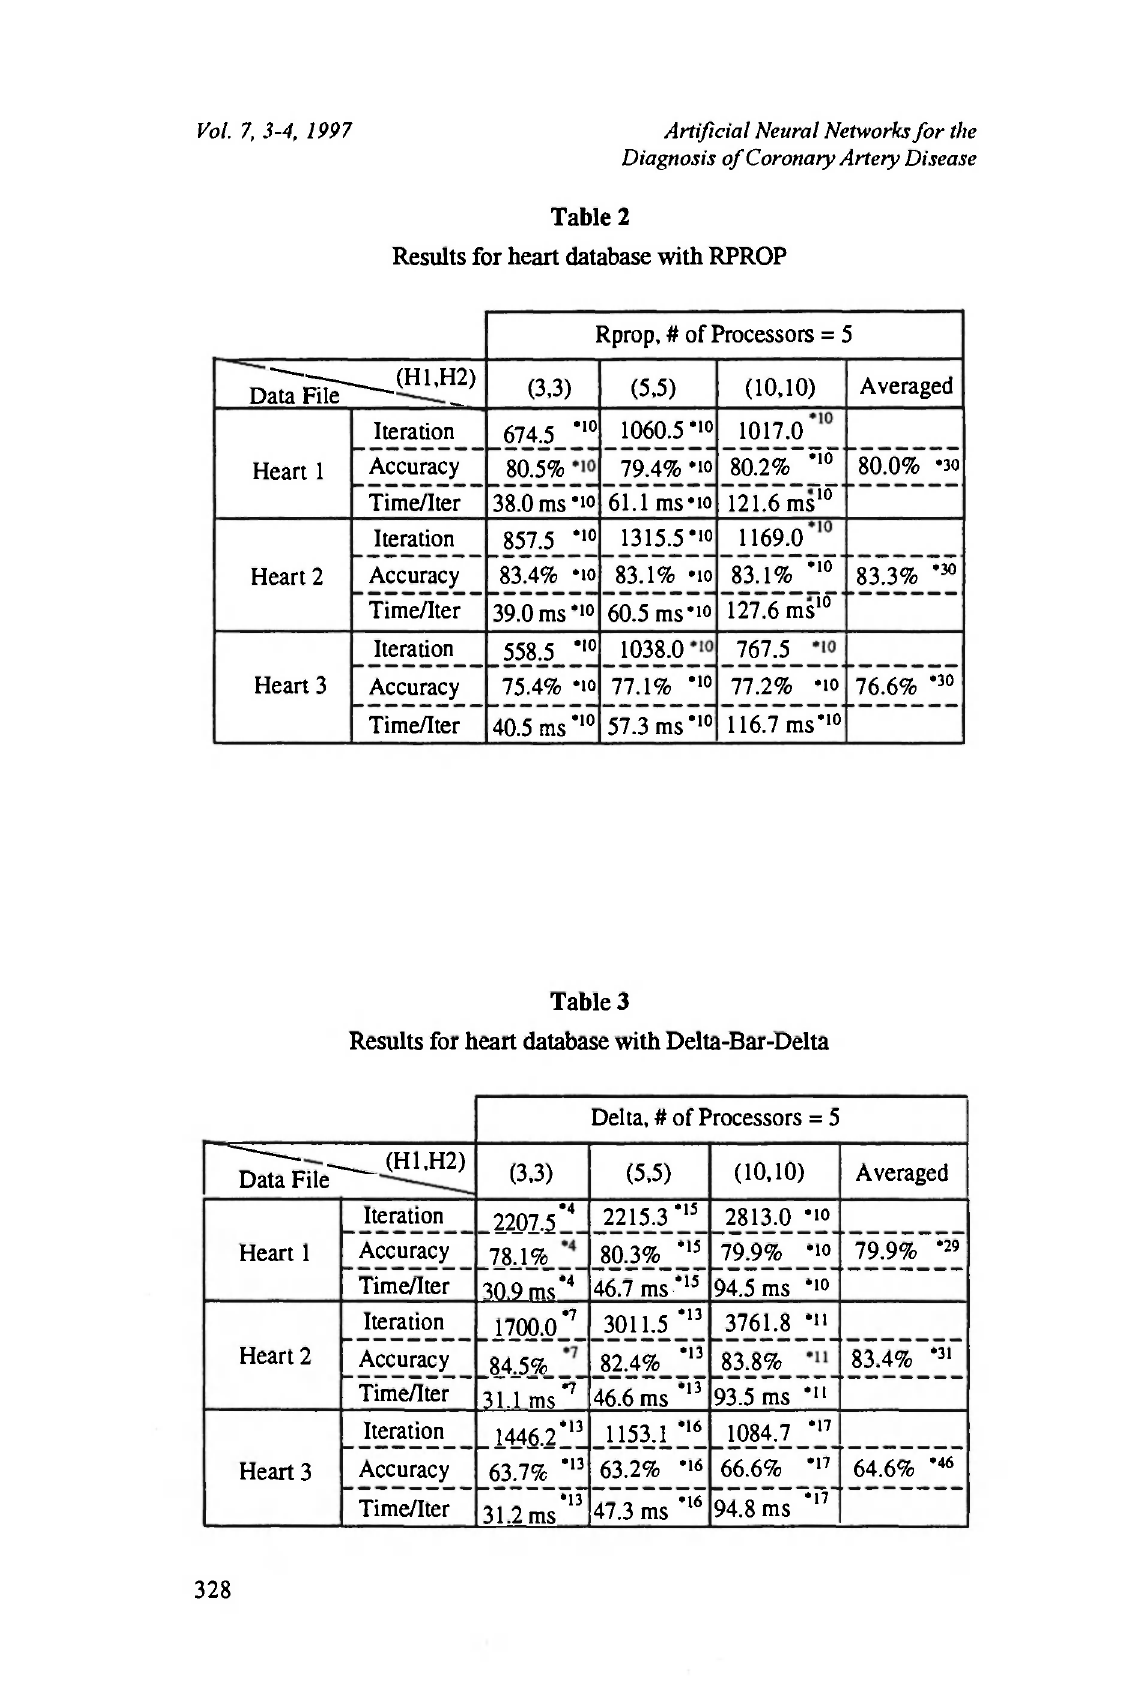
Results for heart database with RPROP